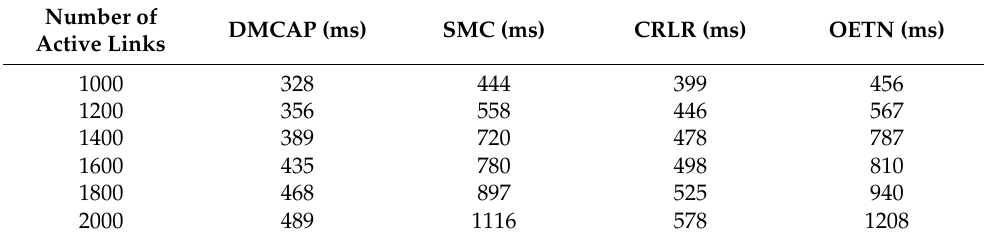
Table 4. Time complexity.